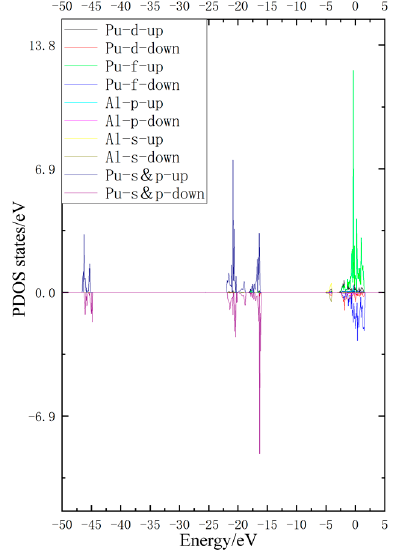
Figure 9. PDOS of Pu-Al system.